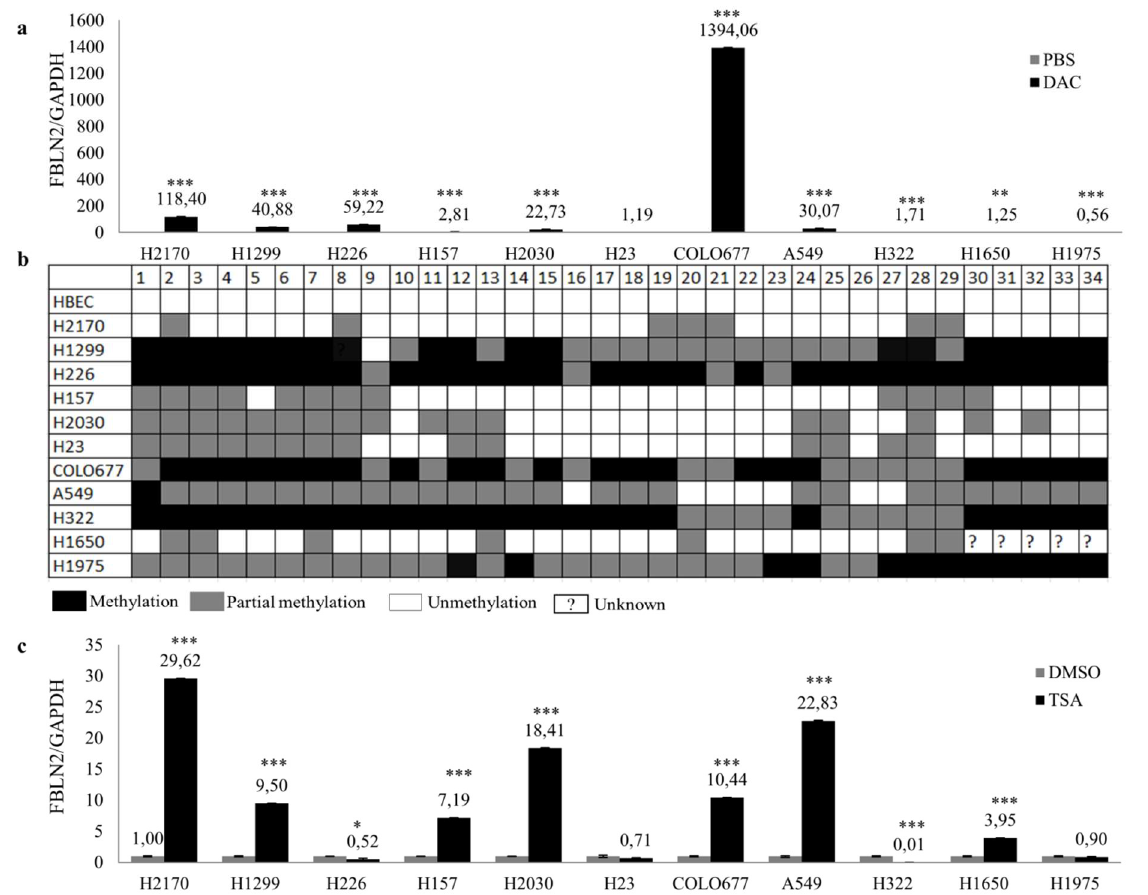
Figure 2. Epigenetic regulation of FBLN2 in normal human bronchial epithelial cells and lung cancer cell lines. ( a ) mRNA expression of FBLN2 was measured by real-time RT-PCR after demethylation treatment with 5 µM of 5-aza-2′-deoxycytidine (DAC); ( b ) Methylation status of FBLN2 in the promoter region was analyzed by using bisulfite sequencing; ( c ) mRNA expression of FBLN2 was analyzed after the cells were treated with the histone deacetylase inhibitor Trichostatin A (TSA). mRNA expression level compared to GAPDH in untreated cells was set to 1.0. * p < 0.05, ** p < 0.01, *** p < 0.001.